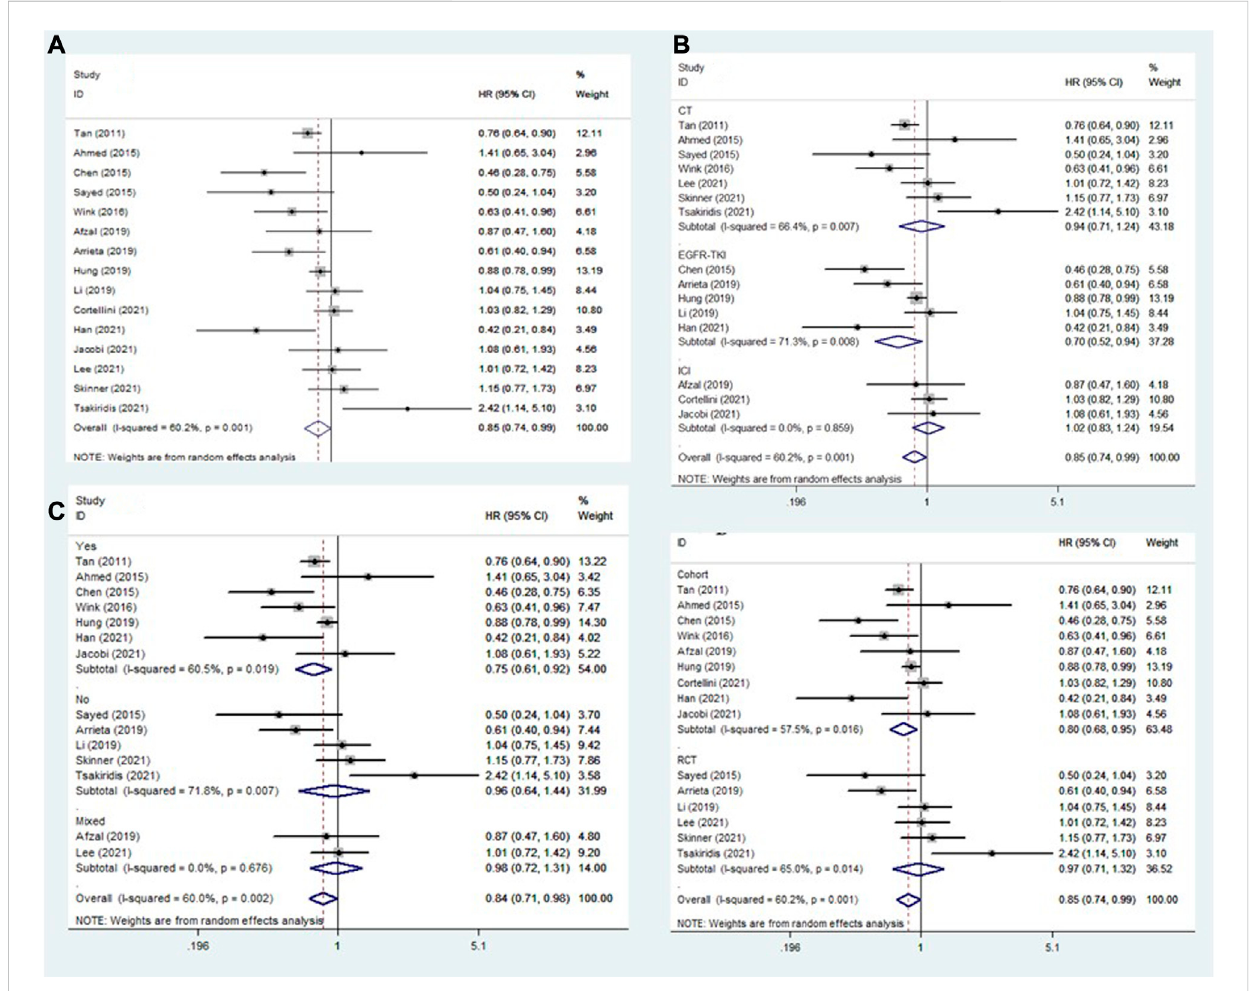
FIGURE 3 The association between metformin use and progression-free survival in (A) all NSCLC patients; (B) subgroups by treatment type; (C) subgroups by comorbidity of diabetes mellitus; and (D) subgroups by study design. NSCLC: non-small cell lung cancer.